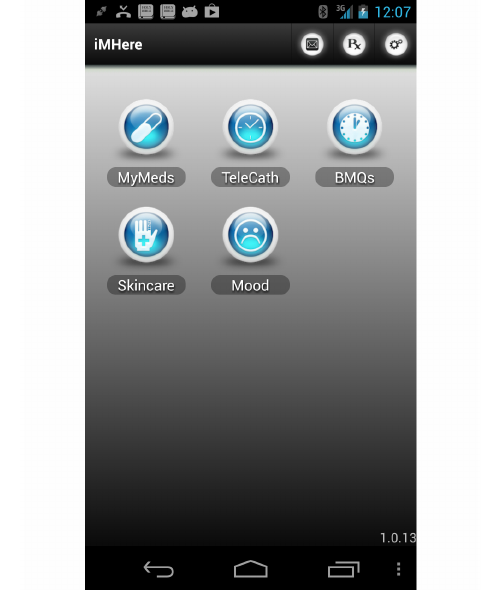
Figure 2. Home screen for suite of apps. App selection area launches individual apps and common action bar initiates tasks within all apps.